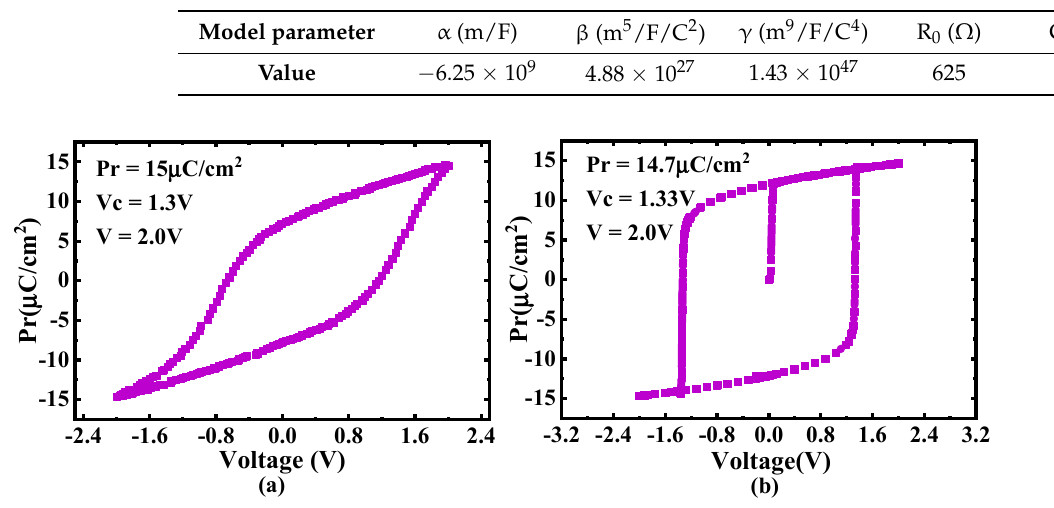
Table 2. Model parameters of the FeCAP model.